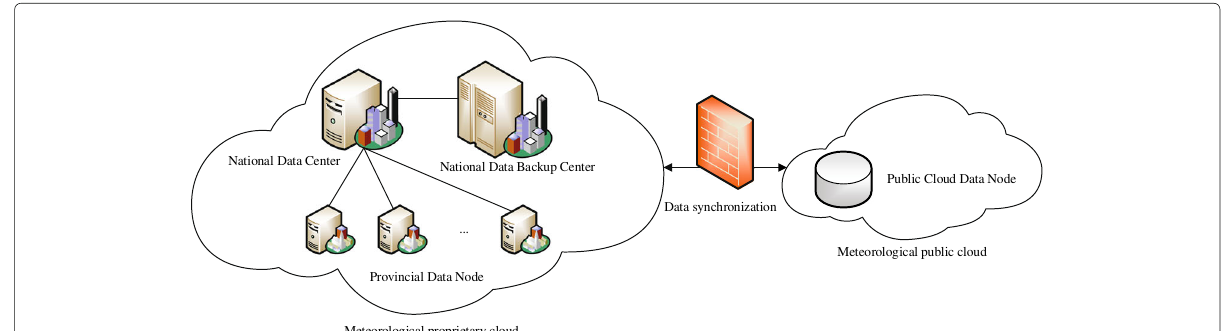
Fig. 1 A Framework of the meteorological cloud